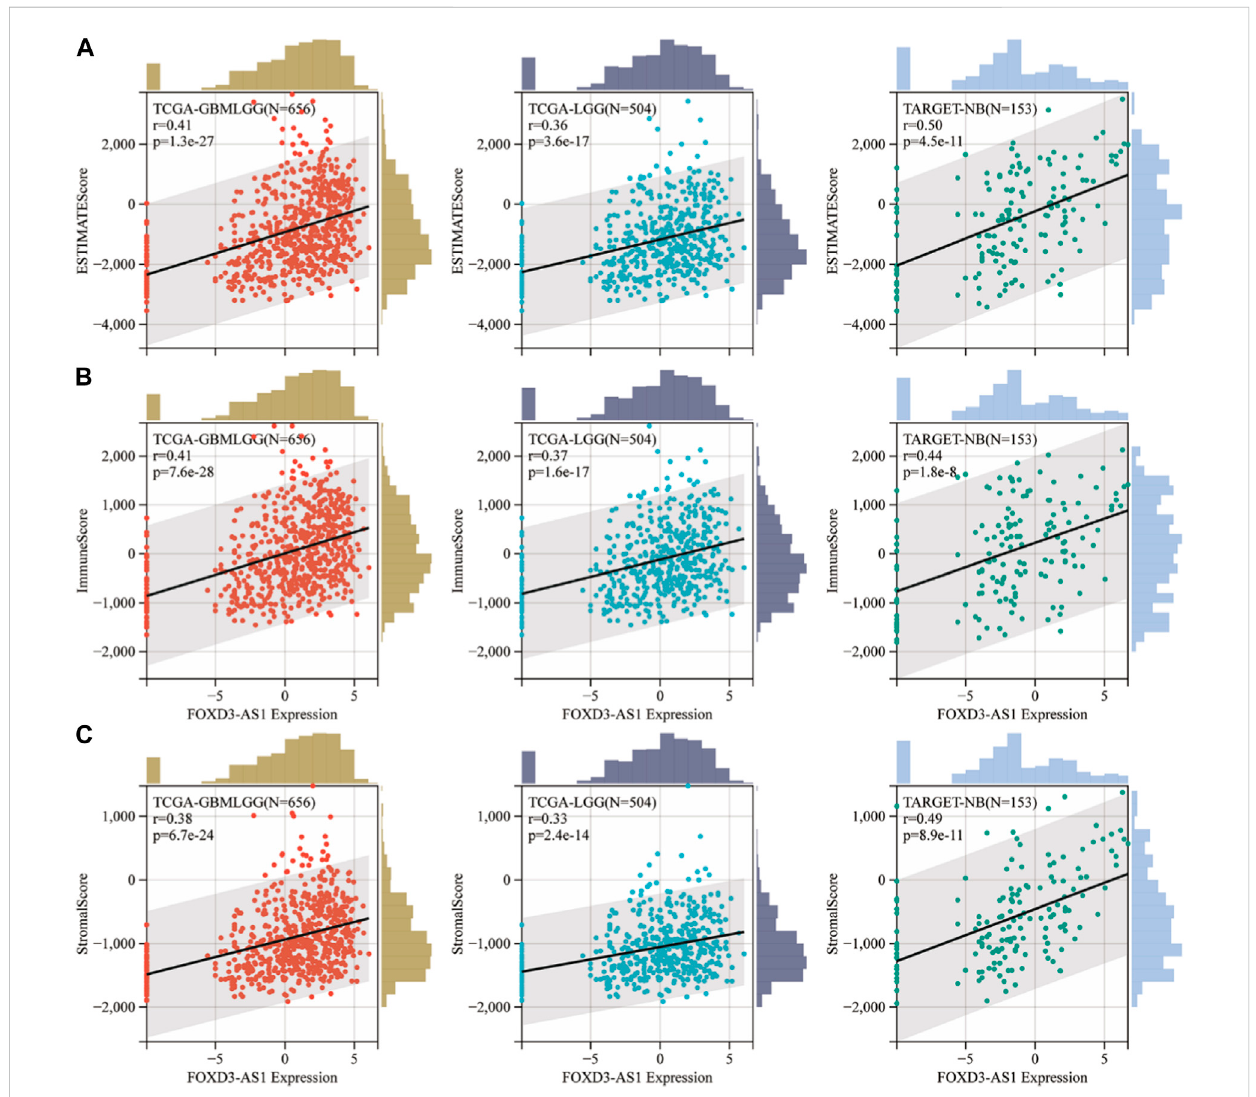
FIGURE 12 ESTIMATE algorithm was used to analyze the immune in fi ltration status of FOXD3-AS1 in tumors. Scatter plots of the fi rst 3 signi fi cant correlations between FOXD3-AS1 expression and ESTIMATEScore (A) , ImmuneScore (B) and StromalScore (C) .